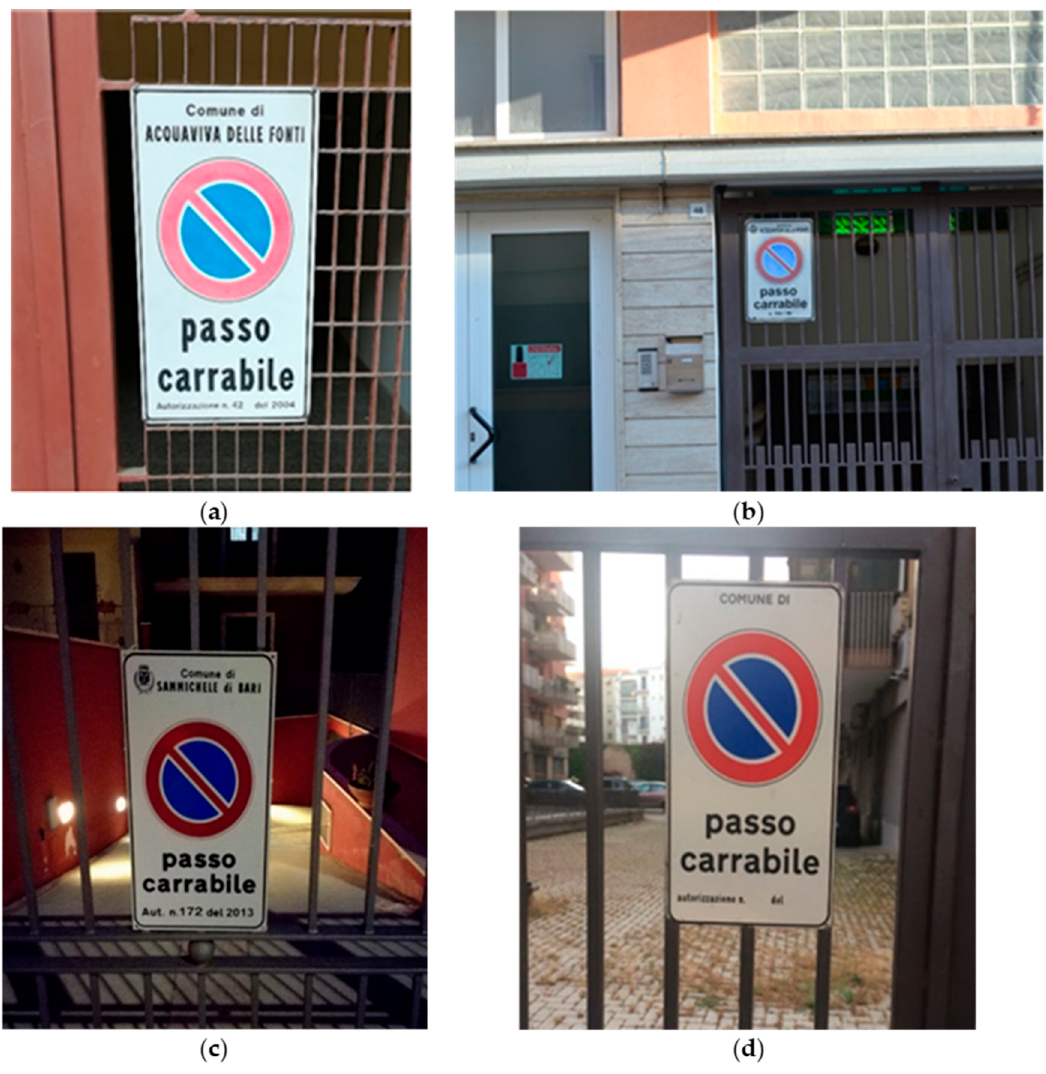
Figure 3. Examples from the classes of the tow-away road sign image dataset: (a) C1: Close distance and simple scenario; (b) far distance, complex scenario; (c) poor lighting; (d) false road sign or license code featuring missing/wrong information.